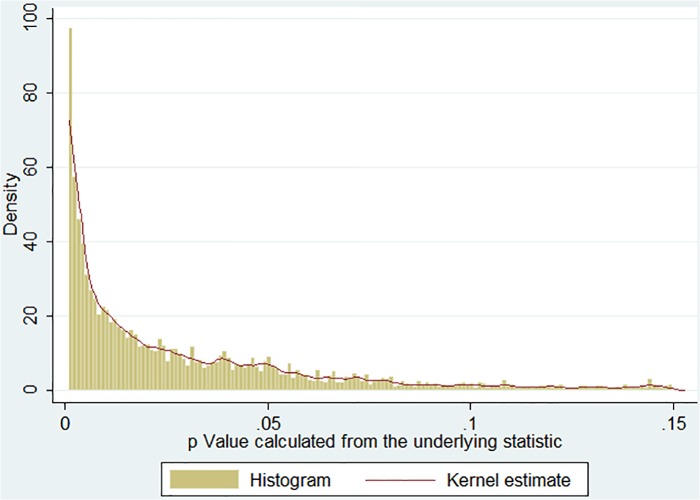
Distribution of re-calculated actual p values (restricted to .001–.15, equal weight of each paper).